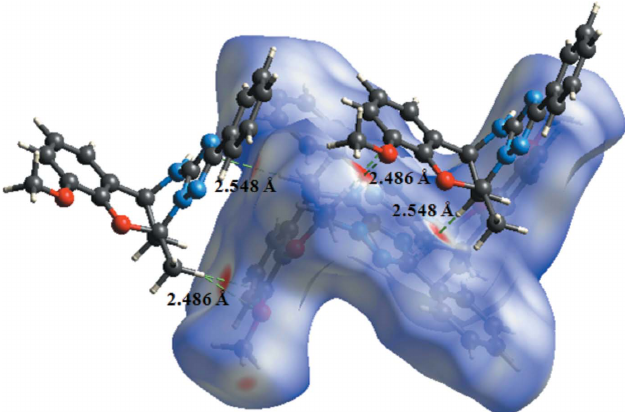
Figure 2 The view of the crystal packing of C 19 H 18 N 4 O 2 . Dashed lines denote the N—H (cid:3)(cid:3)(cid:3) N and C—H (cid:3)(cid:3)(cid:3) O hydrogen bonds.